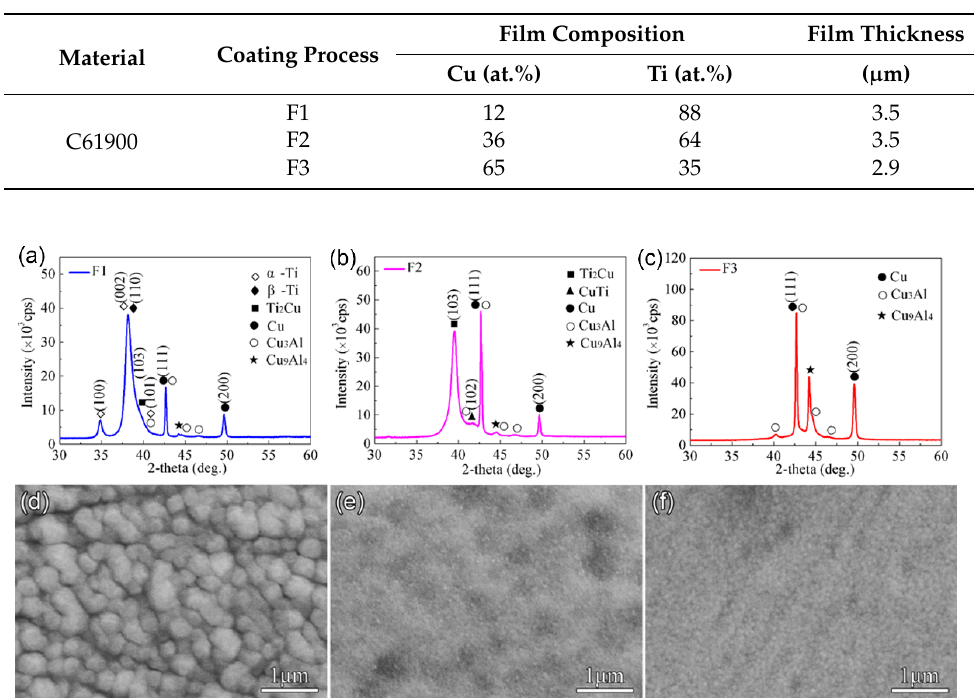
Table 4. The composition and thickness of the Cu-Ti films fabricated by magnetron sputtering on C61900 Cu alloys.